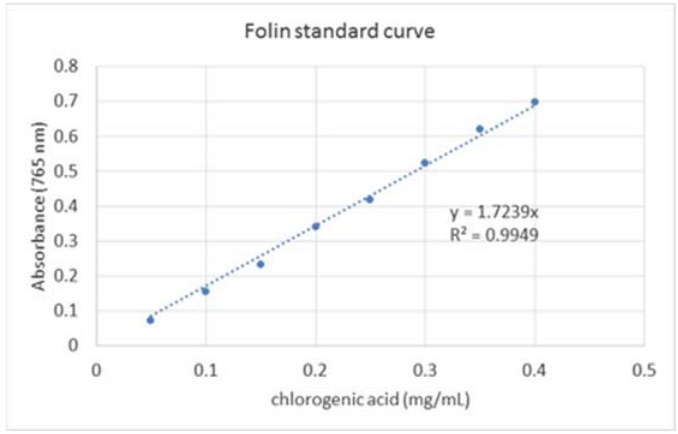
Figure 7. Calibration curve of chlorogenic acid (5-CQA) used for spectrophotometric analyses.